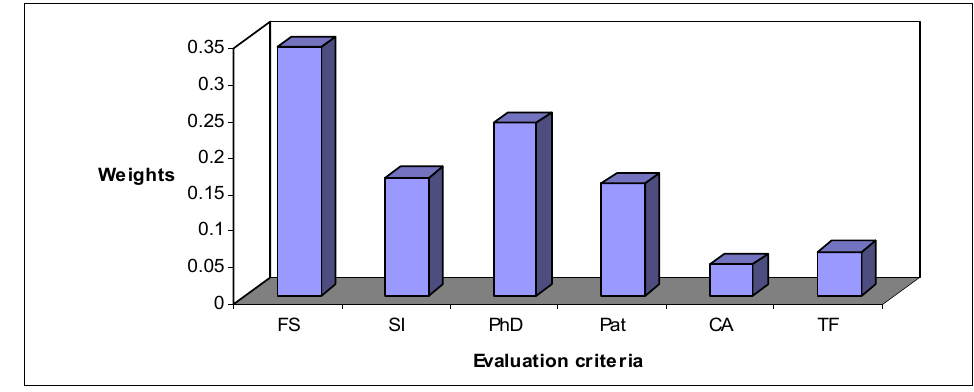
Fig. 5. Relative weights for evaluation